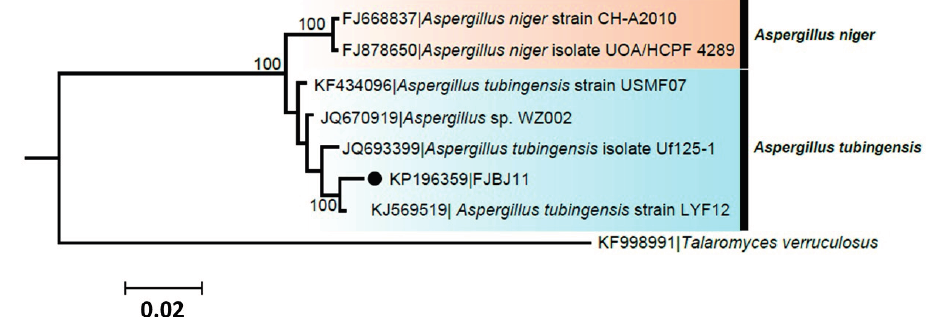
Figure 2. Phylogenetic relationship of isolate FJBJ11 (accession No. KP196359) to representative sequences of known A. tubingensis and A. niger . Reference sequences were retrieved from GenBank and a T. verruculosus strain (accession No. KF998991) was served as an outgroup. The numbers on the branches are posterior probability (only shown >50) supporting the branch pattern. The isolate FJBJ11 from current study is marked with black dot. The distance unit is